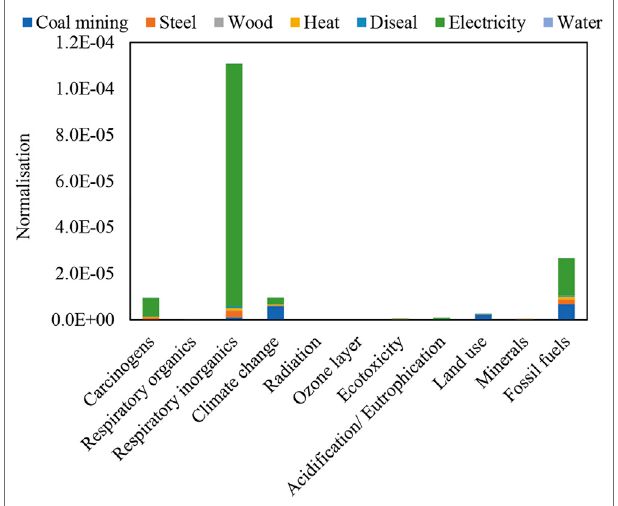
FIGURE 5 | Normalized results of LCIA taking 20 m coal pillar as an example.